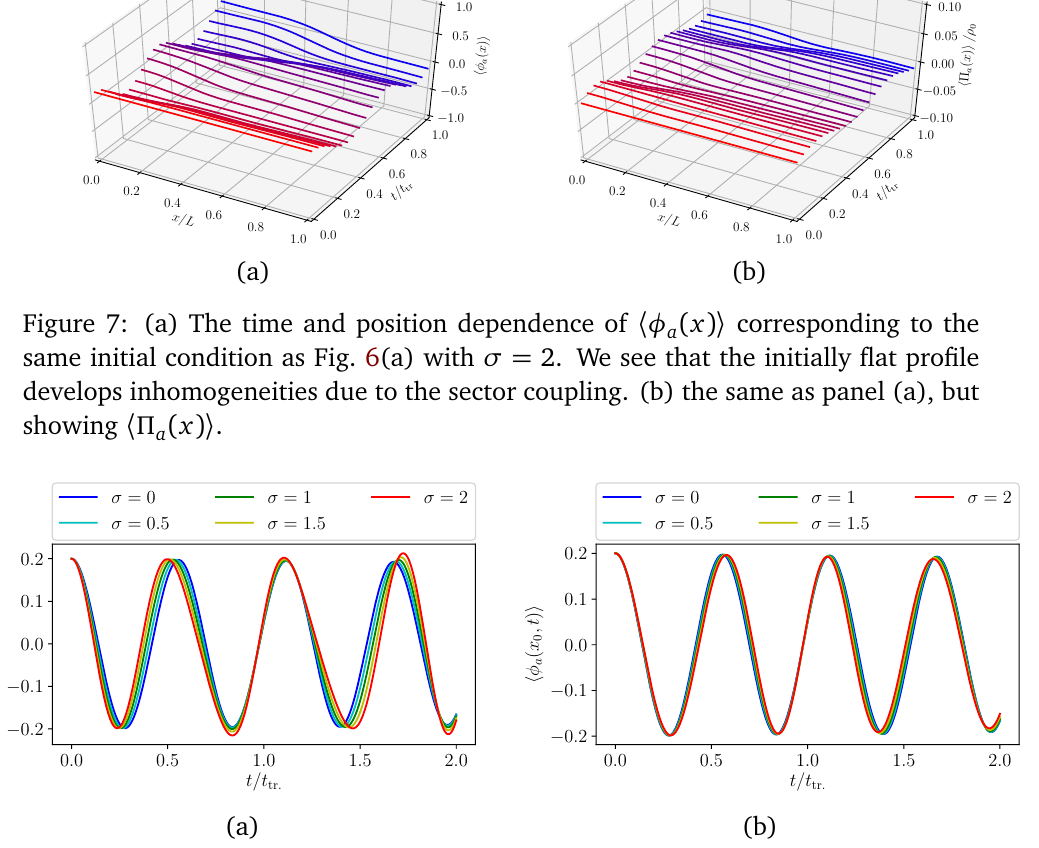
Figure 8: Time dependence of the relative phase in the centre of the box for the same initial conditions as Fig. 6(a) and (b), respectively.